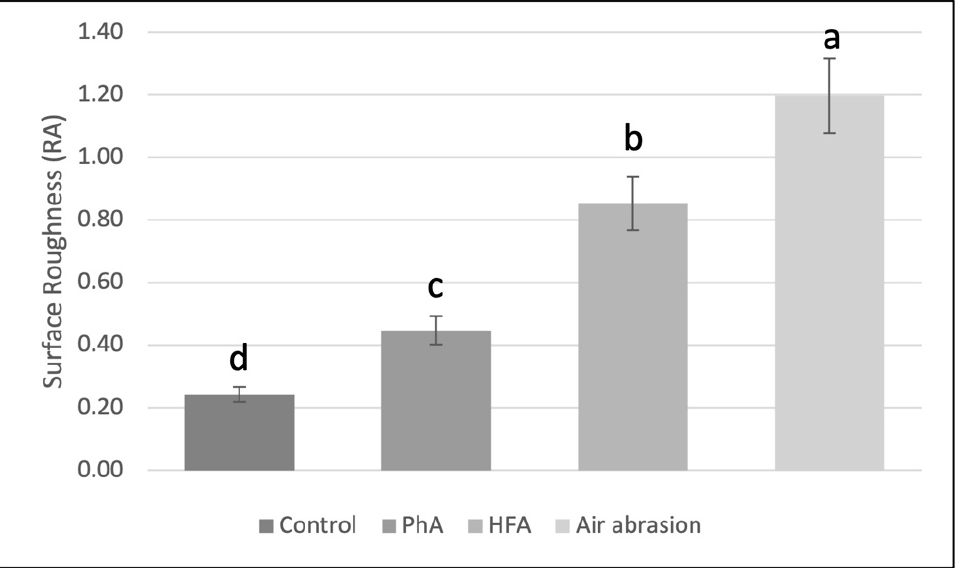
Figure 3. Ceramic surface roughness results. Values with different superscript letters indicate significant differences ( p < 0.05) (a > b > c > d).